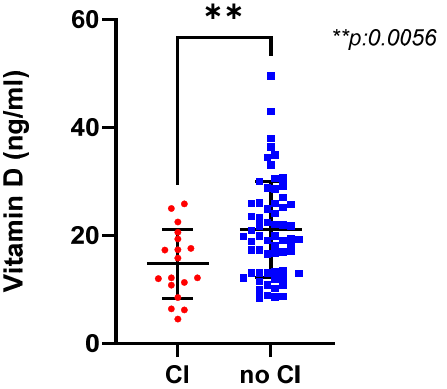
Figure 1. Scatter plots showing mean values and standard deviations of serum vitamin D at diagnosis in patients with preserved and impaired cognitive function (CI), defined as slowed information processing speed evaluated by the Symbol Digit Modalities Test. Patients with CI displayed significant lower values of vitamin D ( p = 0.0056), and no patient with CI showed a normal value of vitamin D. We confirmed the relationship between hypovitaminosis D and slowed IPS by also performing a univariate analysis, as highlighted in Figure 2A for raw values ( r s: 0.38, p -value: 0.0005) and B for z -scores ( r s: 0.33, p -value: 0.002). This association was confirmed after correction for sunlight exposure ( r : 0.392, p : 0001 raw values; r : 0.355, p : 001 with z -scores) and after correction for MRI parameters ( r : 0.38, p : 0.01 raw values; r : 0.339, p : 0.002 with z